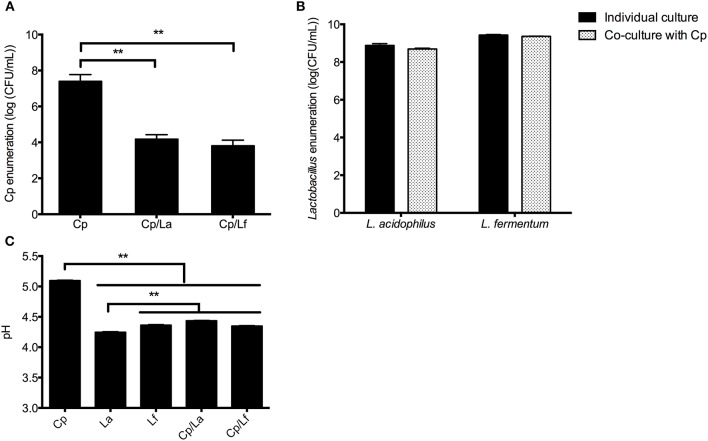
Bacterial enumeration and pH measurement in the co-culture experiment. Lactobacilli and C. perfringens were individually or together inoculated into the MRS broth with equal CFU and cultured at 37°C for 20 h. The enumeration of C. perfringens
(A) and lactobacilli (B) as well as pH values of cultures (C) were determined at the end of incubation. Data are presented as mean ± standard error (n = 3). **P < 0.01. La, L. acidophilus; Lf, L. fermentum; Cp, C. perfringens.